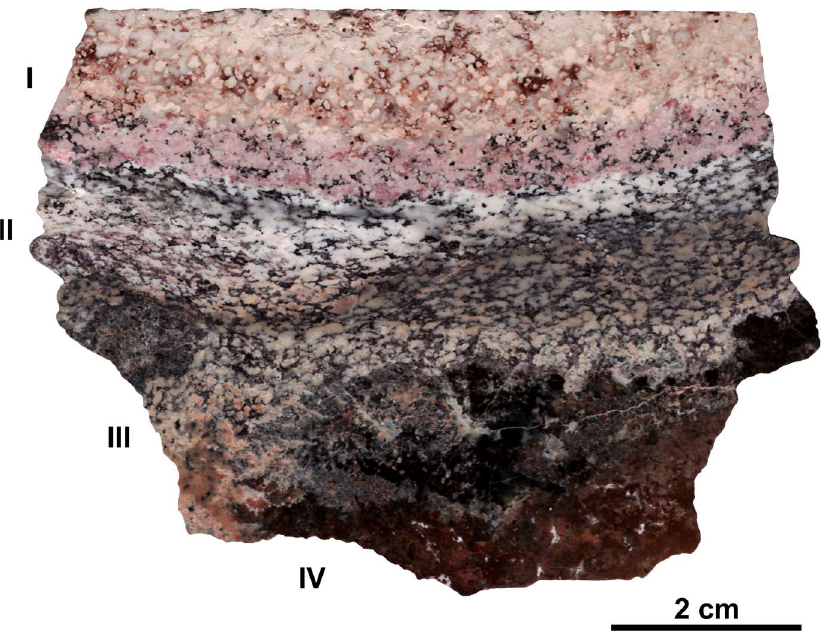
Figure 1. Xenolith specimen from Bellerberg with characteristic multi-coloured zones: I-III—xenolith, IV—altered alkali basalt (description in text).